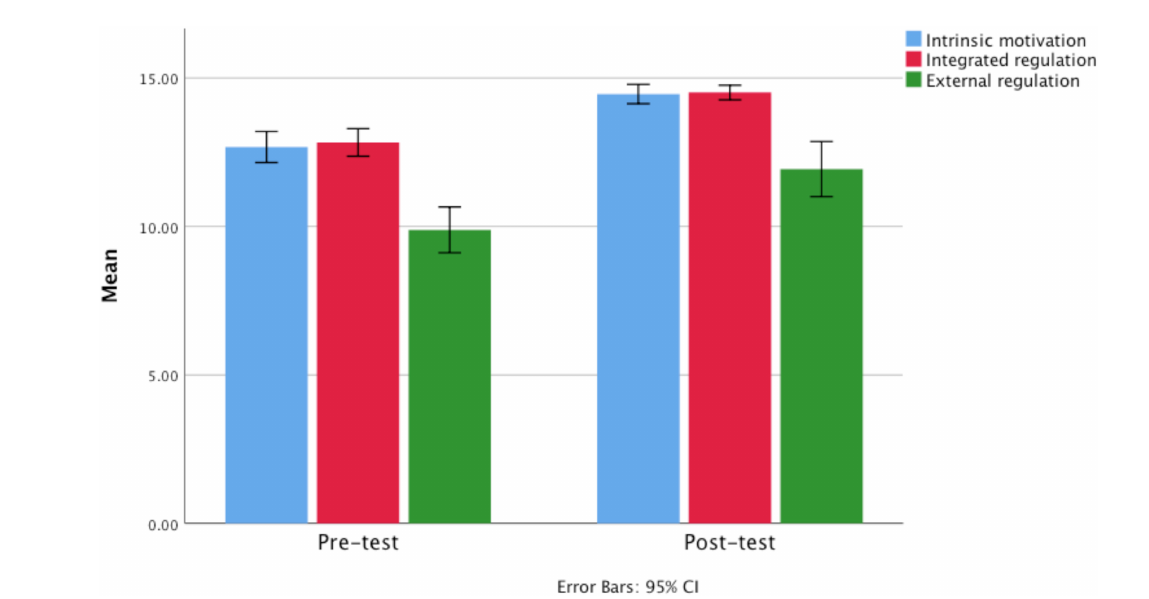
FIGURE3 The effect of training on teachers’ motivation for work.